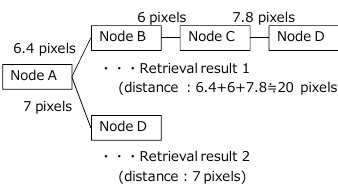
Figure 6. Sample of path finding represented with a tree map